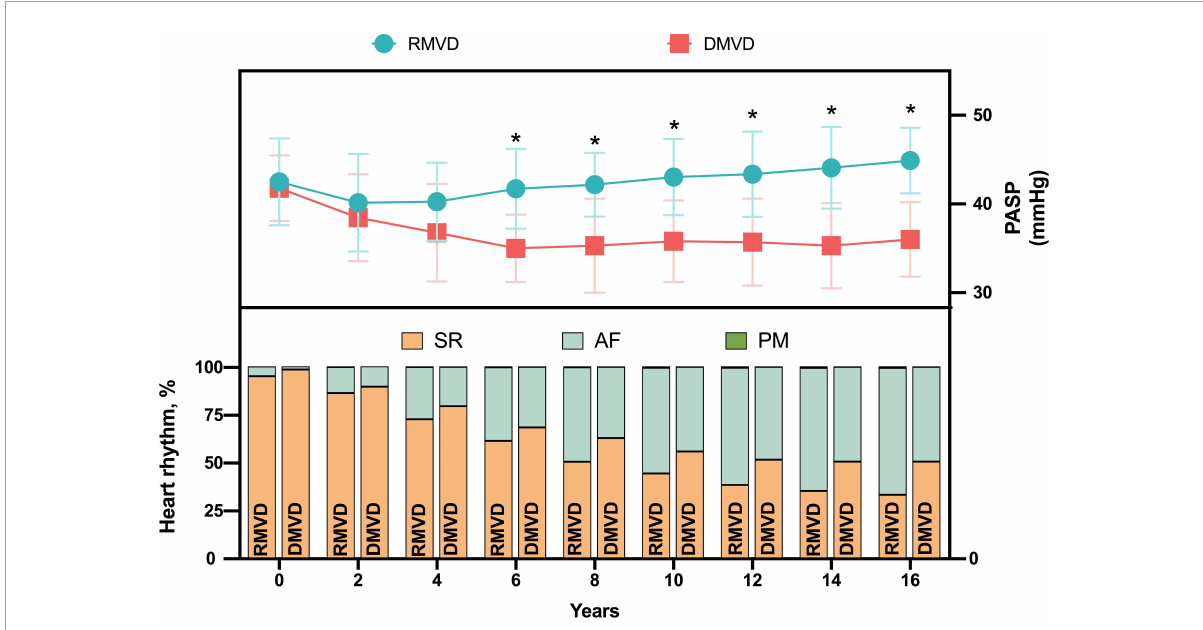
FIGURE6 Heart rhythm according to the changes of PASP during follow-up in patients with MV disease. AF, atrial fibrillation; DMVD, degenerative mitral valve disease; PASP, pulmonary artery systolic pressure; PM, pacemaker; RMVD, rheumatic mitral valve disease; SR, sinus rhythm. * P < 0.05 vs.